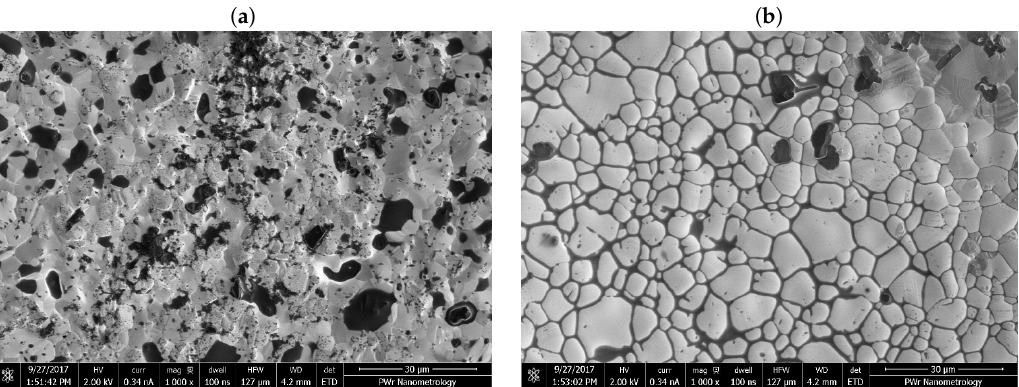
Figure 6. Electrodes surface of the integrated electrochemical cell on LTCC from SEM: ( a ) working electrode—gold and ( b ) reference